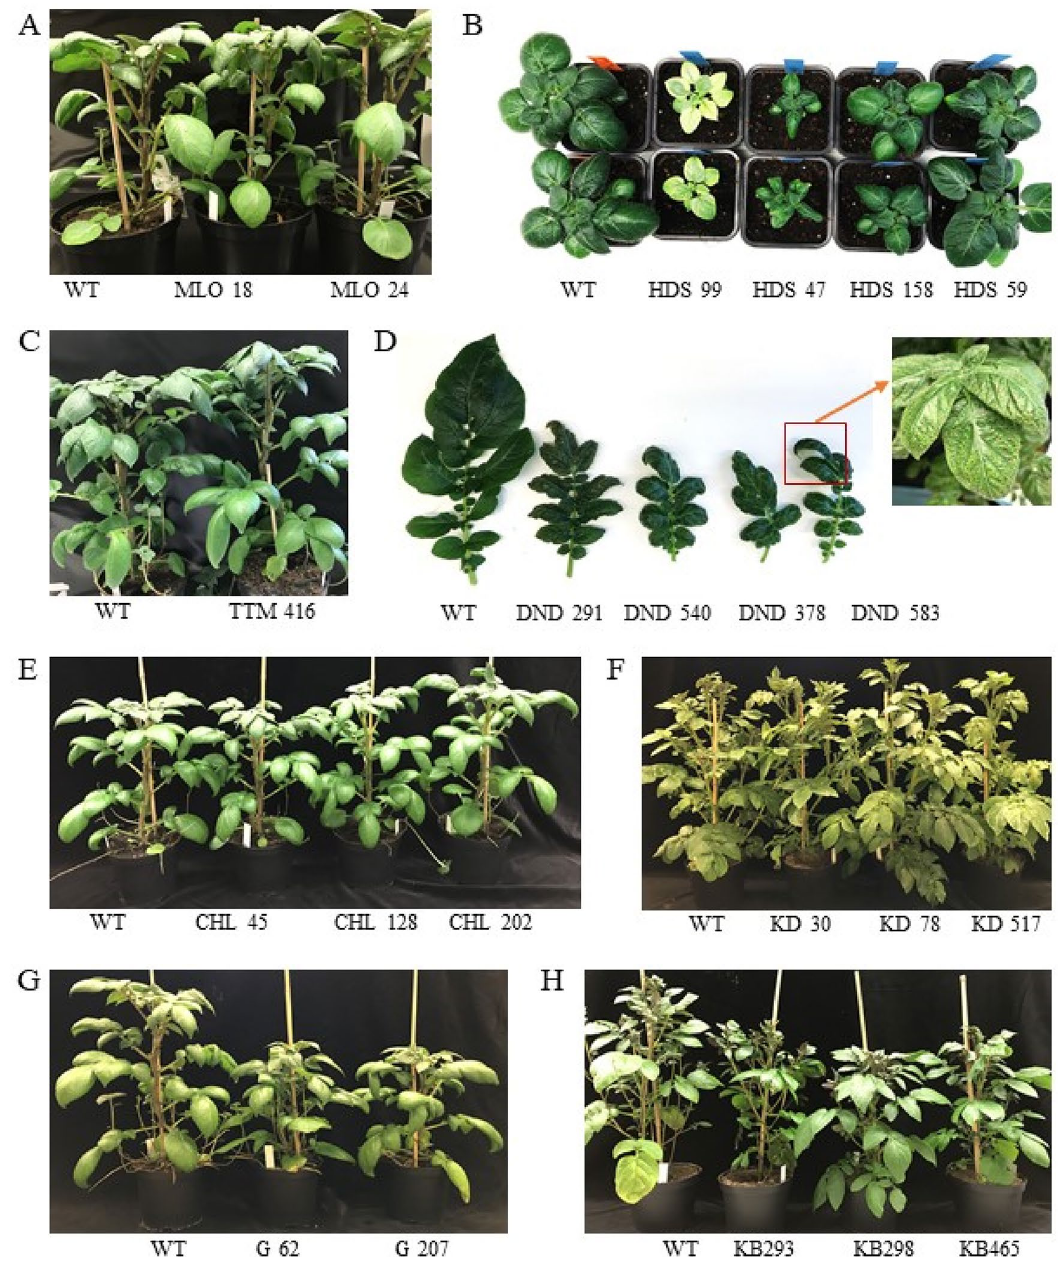
Figure 2. Phenotypes of mutant lines. ( A ) mlo at 5-weeks old stage. ( B ) Wild type Désirée and hds mutant lines at 2-weeks-old stage. ( C ) Wild type Désirée and one Stttm2 mutant line. ( D ) Leaf phenotype of wild type and some Stdnd1 mutant lines. ( E ) Désirée and Stchl1 mutant lines at 5 weeks old. ( F) Wild type King Edward and Stdmr6-1 mutant lines at 5 weeks old. ( G ) Five weeks old wild type Désirée and Stdmr6-2 mutant lines. ( H ) Wild type King Edward and Stdmr6-2 mutant lines 5 weeks